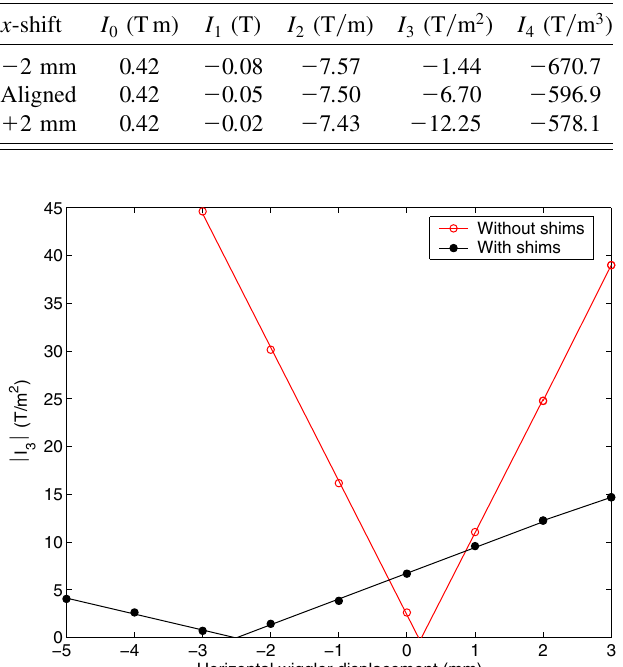
FIG. 17. (Color) Absolute value of I calculated in the central 3 semiperiod as a function of the beam-wiggler misalignment in the configuration with and without the